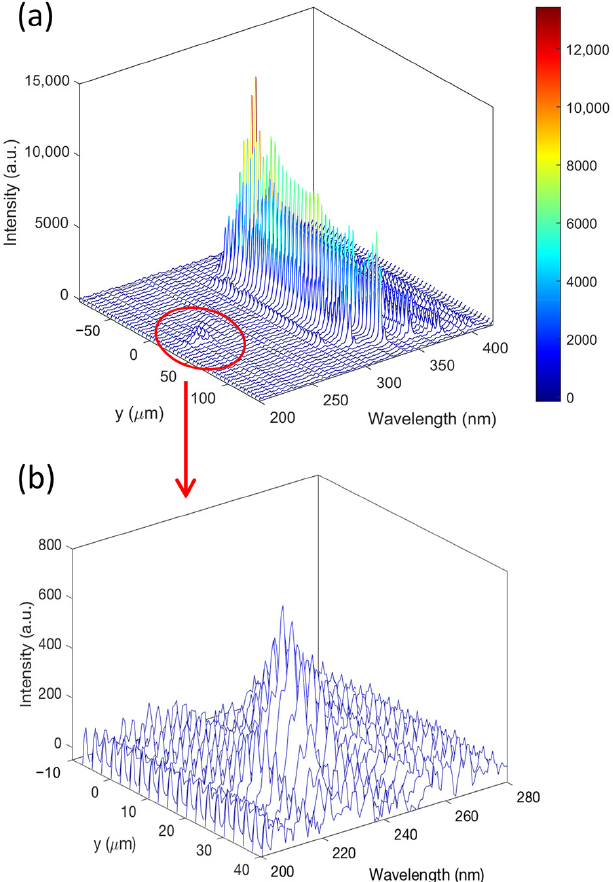
Figure 4. ( a ) A typical spatial-resolved spectrum recorded between 200 to 400 nm as a function of the y direction from − 85 to 140 µ m. The spatial resolution is 5 µ m. The highest signal at 337 nm is attributed to the emission of N 2 (C 3 Π –B 3 Π ) (0–0); ( b ) a zoomed-in plot of the spectral region between 200 to 280 nm with the y direction from − 10 to 40 µ m. The spectrum was recorded with a high spatial resolution of 2.5 µ m. The observed signals are attributed to the emission of NO (A 2 Σ –X 2 Π